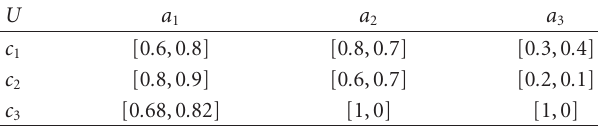
Table 3: Representation of truth membership.